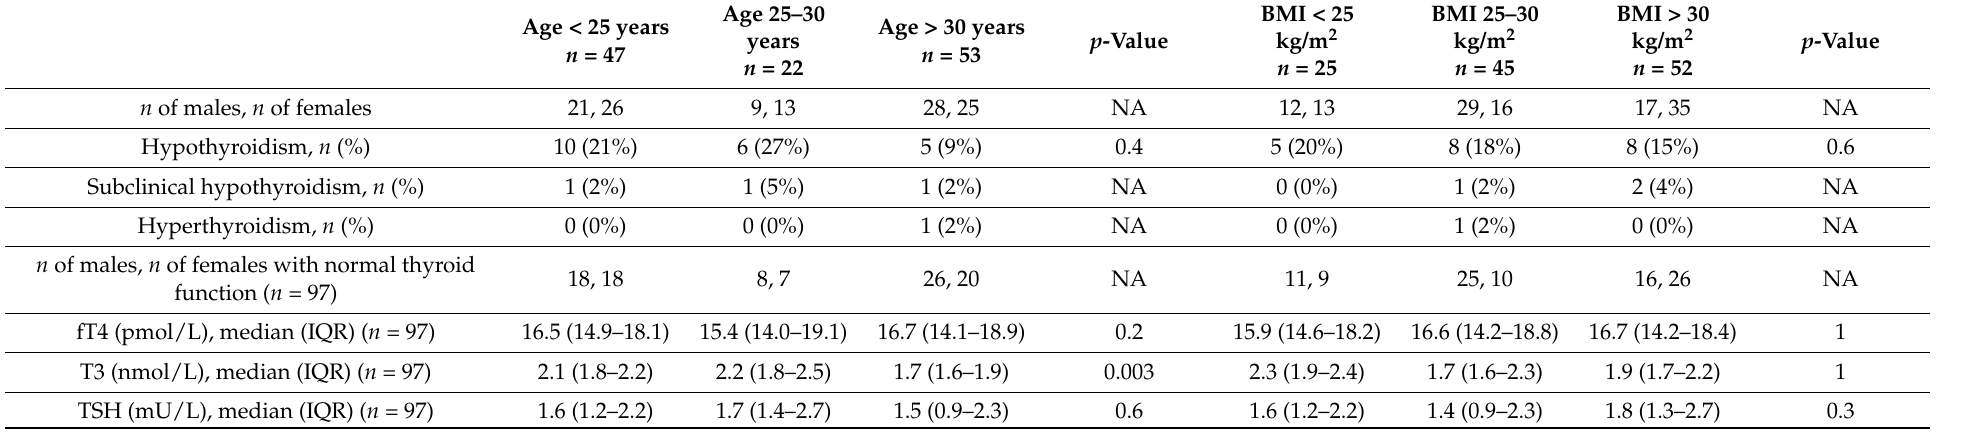
Table 3. Prevalence of hypothyroidism and thyroid hormone levels in 122 patients with PWS (Part 2). Age < 25